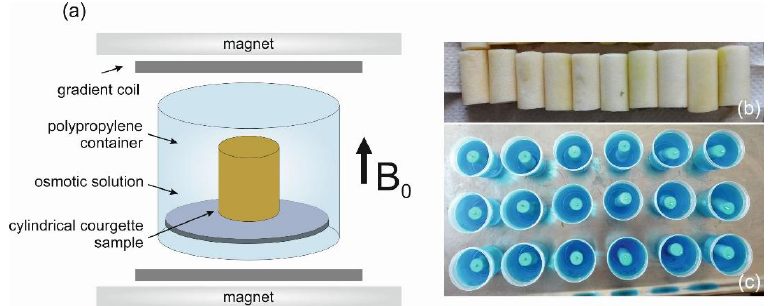
Figure 1. ( a ) Schematic diagram of the experimental setup for the osmotic dehydration of courgette. Photograph of the cylindrical samples of courgette ( b ) before and ( c ) after being placed into the osmotic solution.